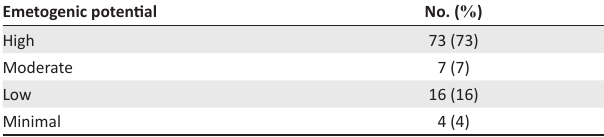
TABLE 2: Distribution of chemotherapy according to emetogenic potential of chemotherapeutic agents ( N =